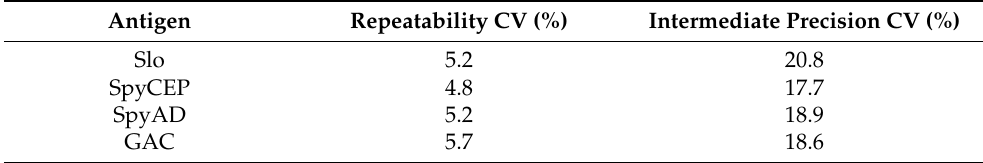
Table 2. Repeatability and intermediate precision calculation. No significant contribution to the variance component was observed by day, operator nor the interaction between day and operator.